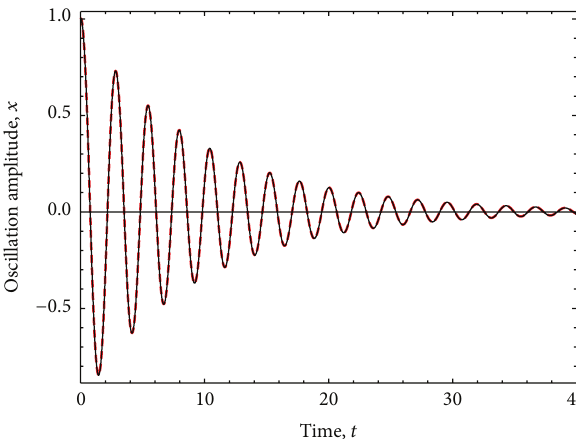
Figure 2: Amplitude-time response curves of (18) and (20). Here, the solid line represents the numerical integration solution of (18), while the dashed line represents the prediction obtained by using thederivedequivalentequationofmotionbyapplyingourenhanced cubication procedure. The parameter values are 𝑎 = 3 , 𝑏 = 4 , and = 175 ∘ ] = 0.1 with 𝑦 10